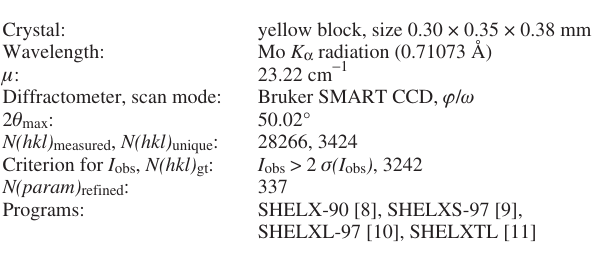
Table 1. Data collection and handling.